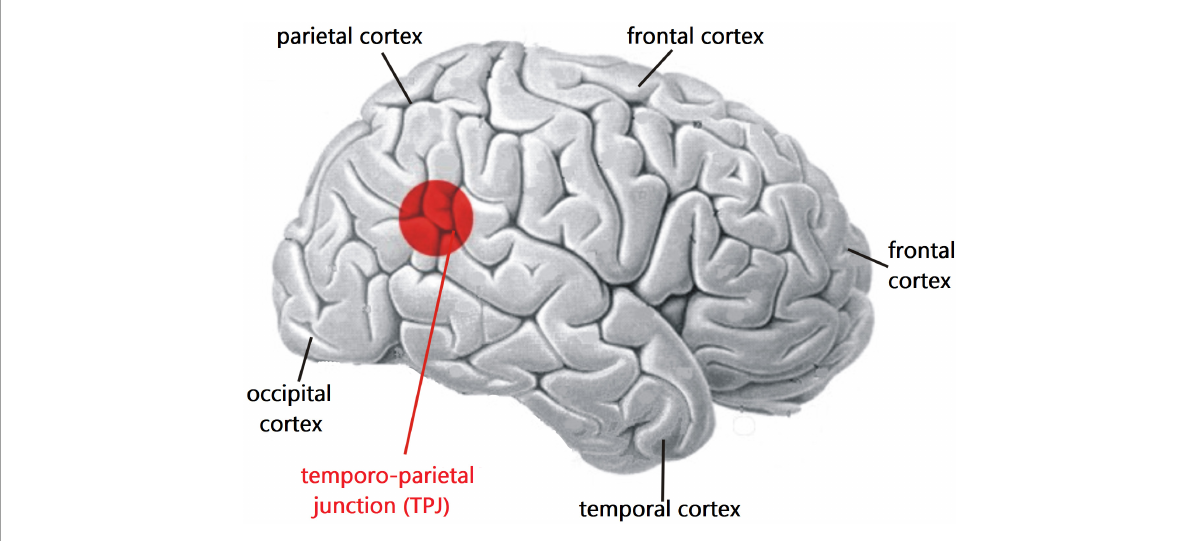
FIGURE1 Location of the temporo-parietal junction (TPJ) on the right-hemisphere cerebral cortex. The TPJ is located where the temporal and parietal lobes meet, not far from the occipital (visual) cortex. Studies have shown that functional modifications of the activation of the TPJ can lead to generating OBEs (compare text). The basic brain model has been modified from Nieuwenhuys et al. (1980), their Fig. 7 (copyright permission by Springer